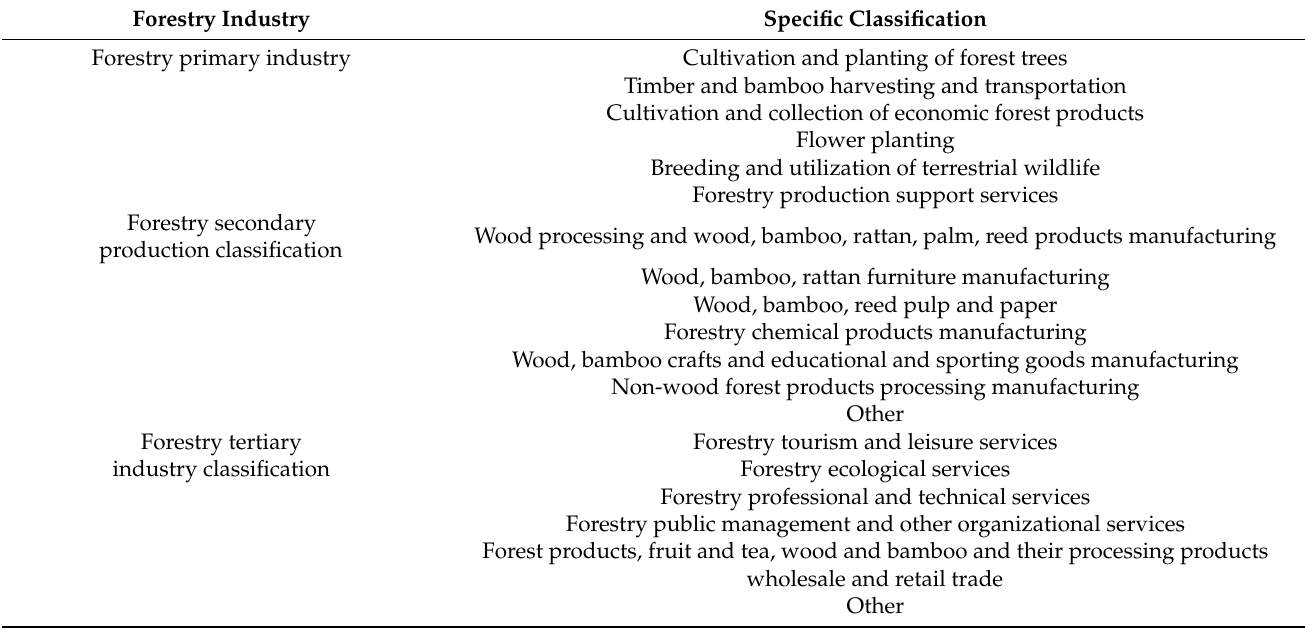
Table A1. Forestry industry and specific